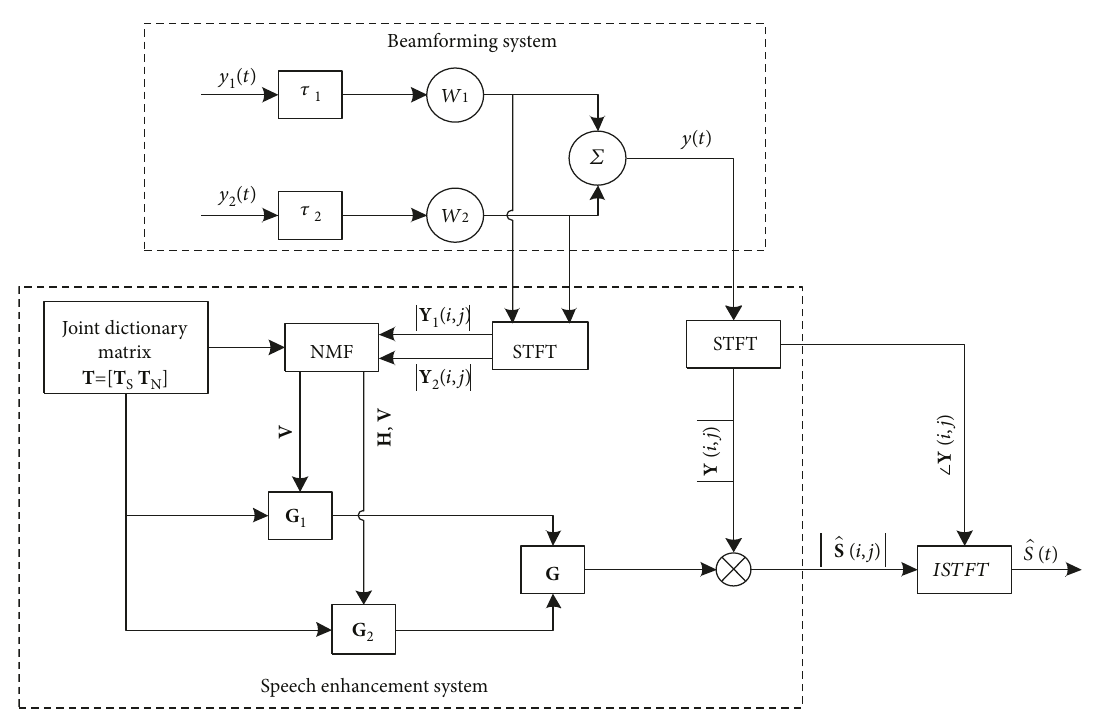
Figure 1: The block diagram of the proposed